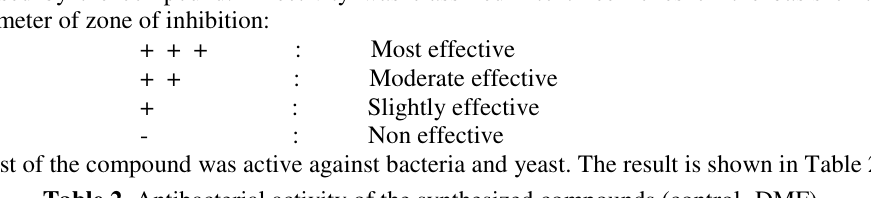
Table 2. Antibacterial activity of the synthesized compounds (control -DMF)